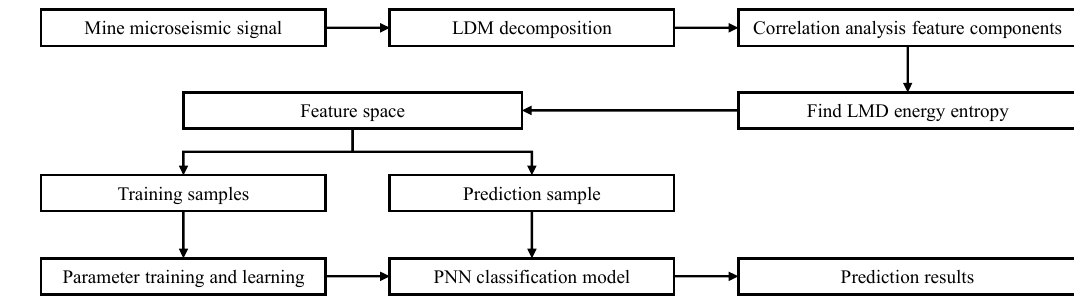
Figure 2. Mine-microseismic-signal-identification process of LMD–PNN.